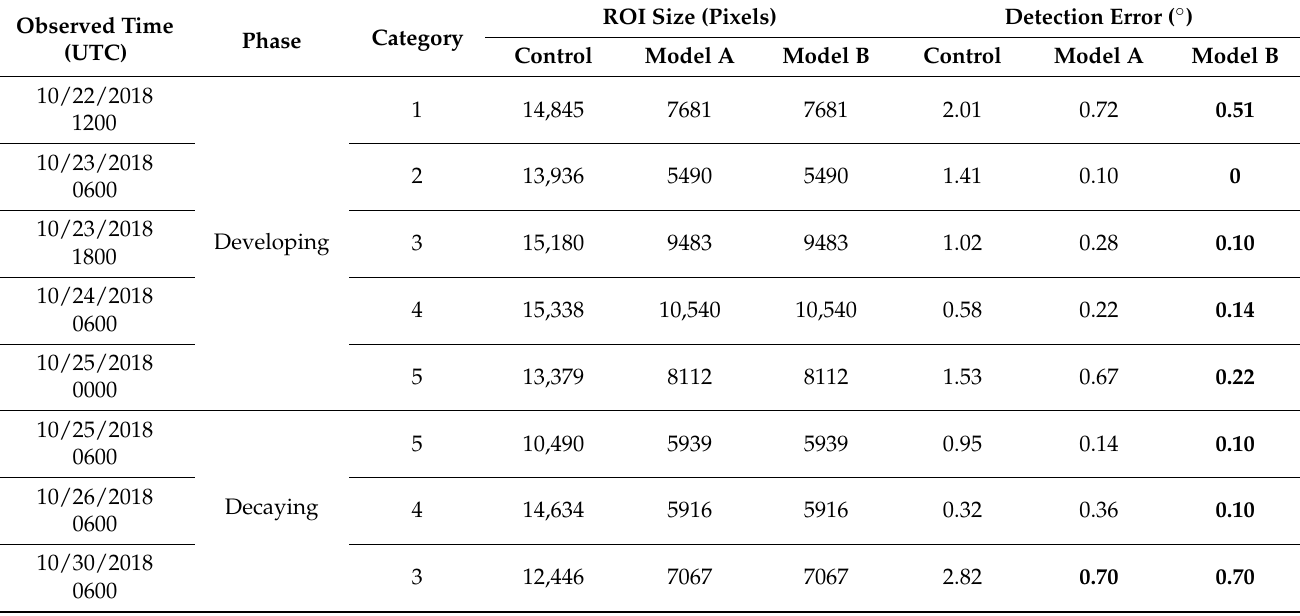
Table 7. Region of interest size and tropical cyclone center detection errors of the control model and models A and B for the eight tropical cyclone cases of typhoon YUTU (2018). The observation time is represented in MM/DD/YYYY hhmn UTC. The most accurate detection result for each tropical cyclone case is shown in